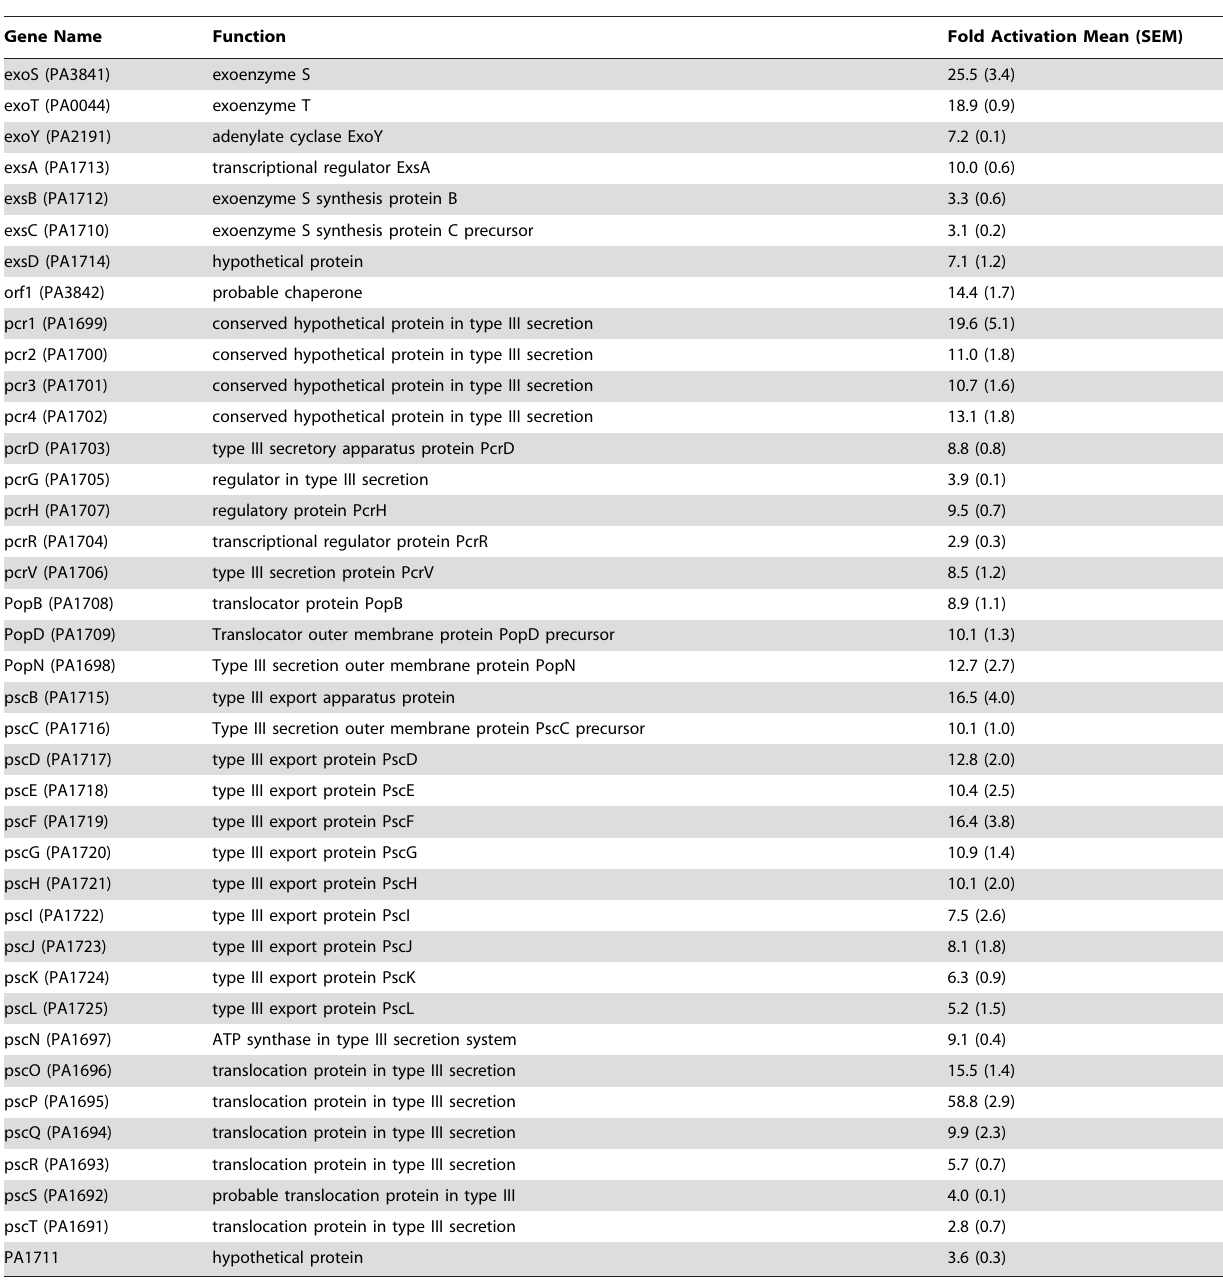
Table 1. Type III Secretion Gene Expression in P. aeruginosa murine GI